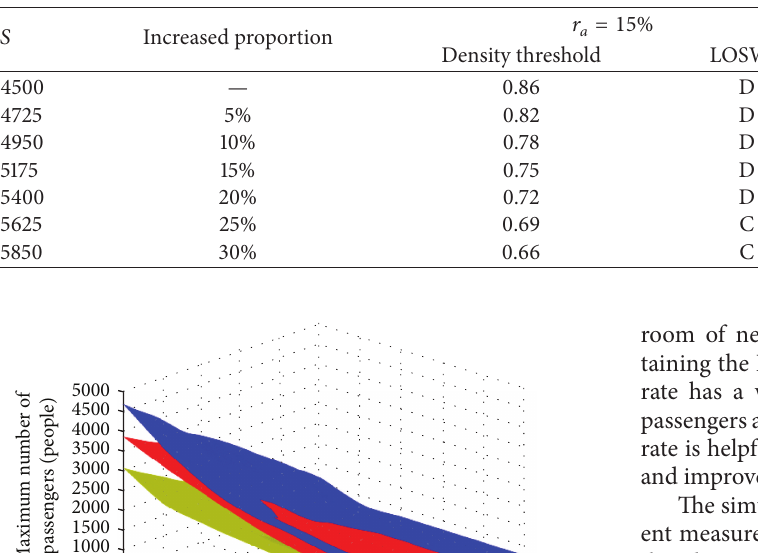
Table 12: The LOSWR varies over the value of S ( 𝑟 𝑎 ).